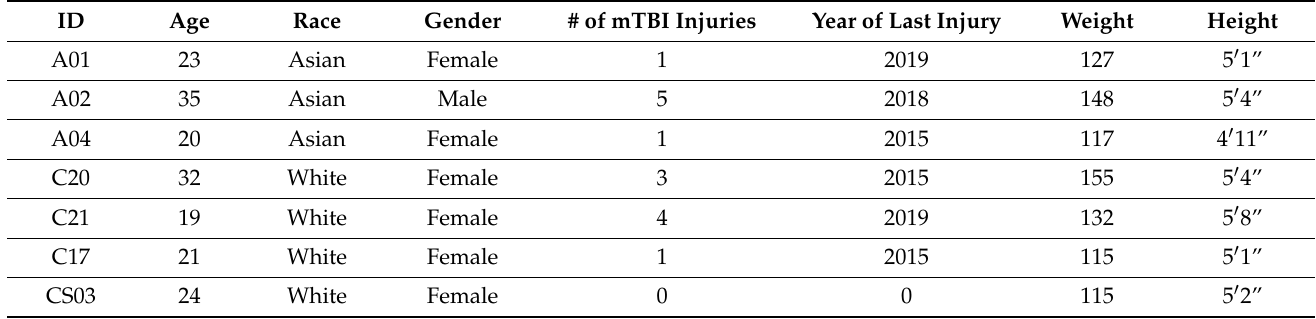
Table 1. Human subjects’ general information.